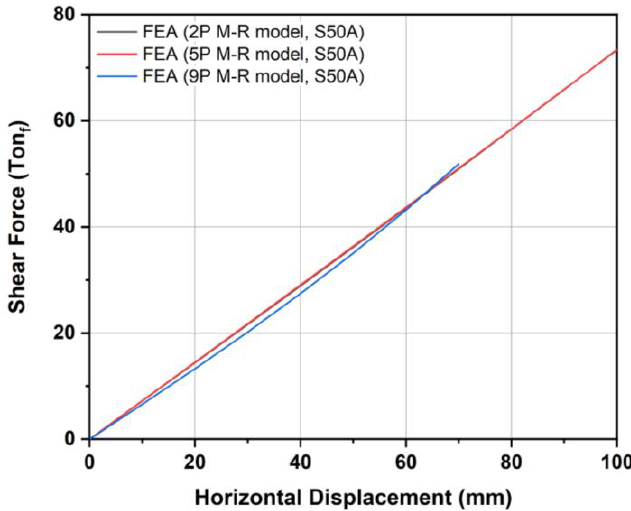
Figure 12. Shear force-displacement graph with respect to the three M-R models through the numerical simulation.